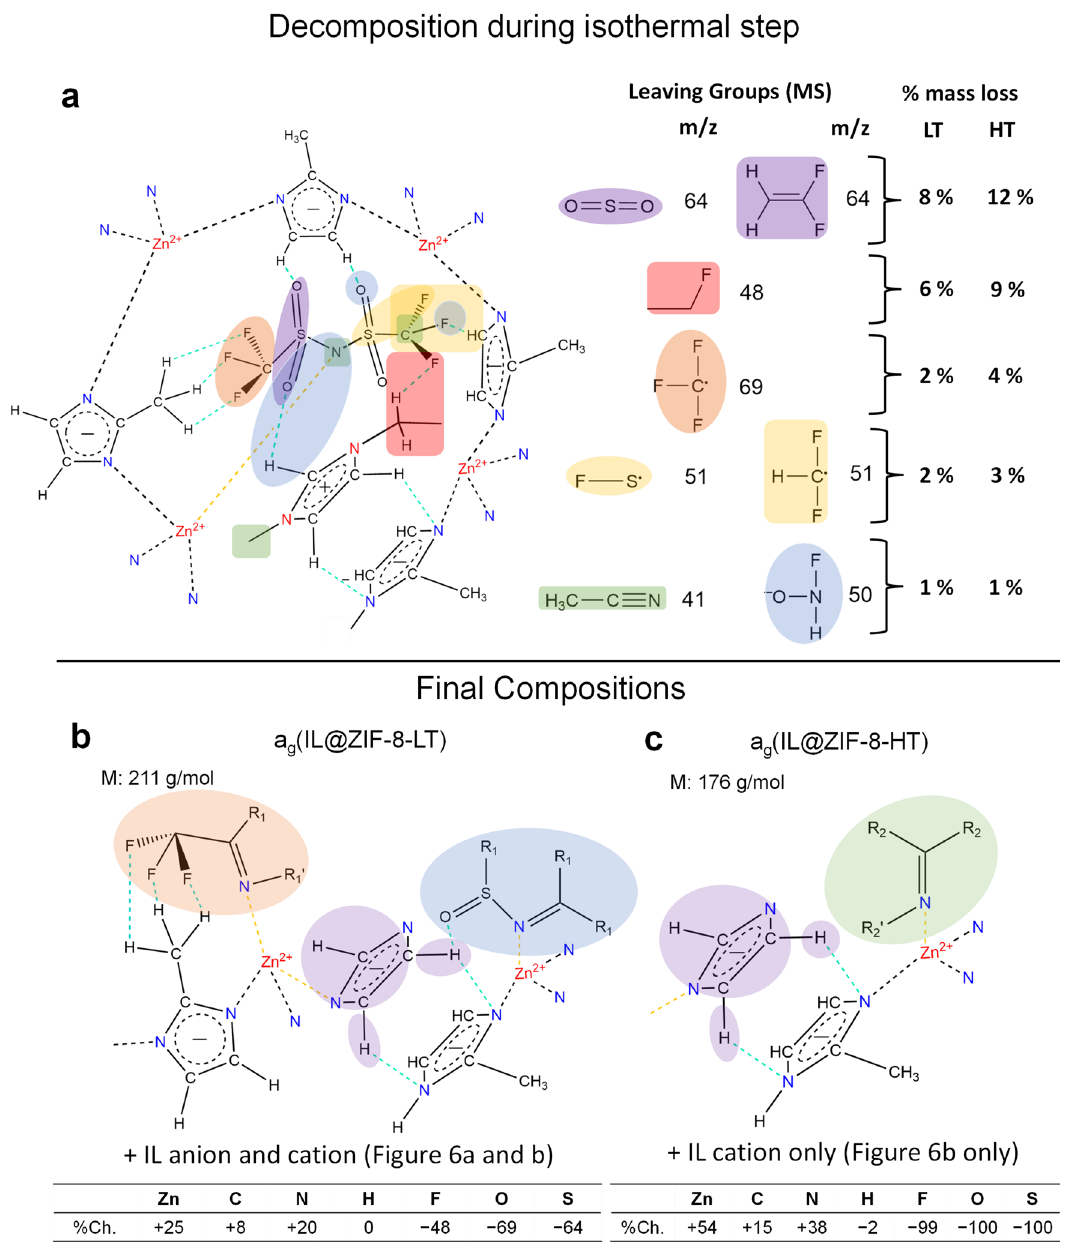
Fig. 7 Route of decomposition and possible fi nal compositions. a Likely leaving groups and their percentages of the total mass loss observed from mass spectrometry. Detected masses <1 wt% loss are not included. Possible fi nal compositions of b a g (IL@ZIF-8-LT) and c a g (IL@ZIF-8-HT) as determined from the peak area of the MS curves. Decomposition products are highlighted. R 1 is H/F or CH 3 − x F x and R 1 ′ is only CH 3 − x F x and, while R 2 is only an H-containing organic group, H or